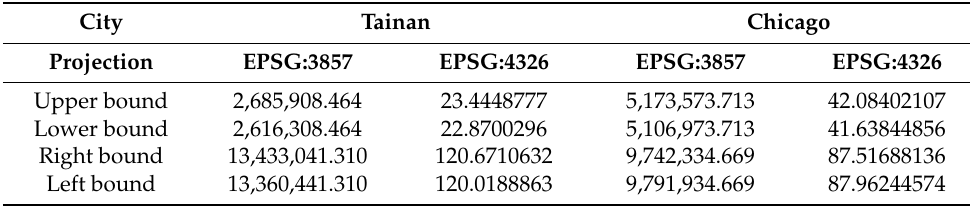
EPSG: 3857 and 4326 projection for grid-like graph of two cities are listed in Table 3. The number of grids in both cities are reduced from 72.36% to 81.34% compared to the road network structure in real world. Table 3. Boundaries for the grid and grid-like graph in Tainan and